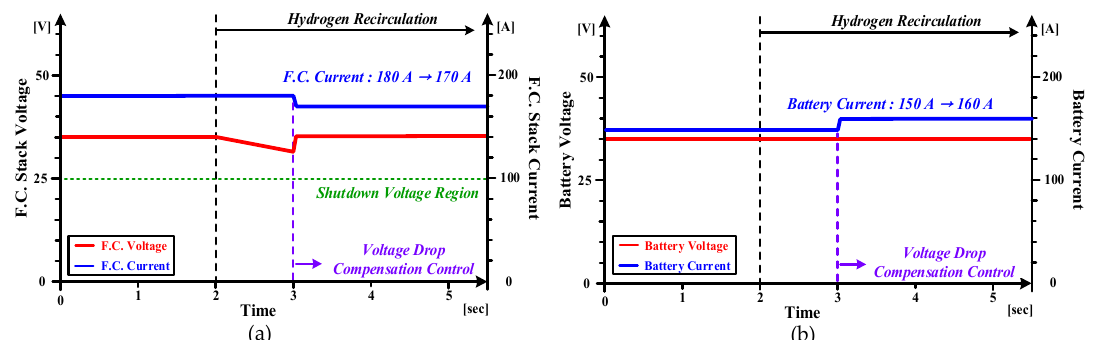
Figure 8. Voltage and current waveforms with proposed voltage drop compensation method during hydrogen recirculation for ( a ) fuel cell stack and ( b ) lithium polymer battery.